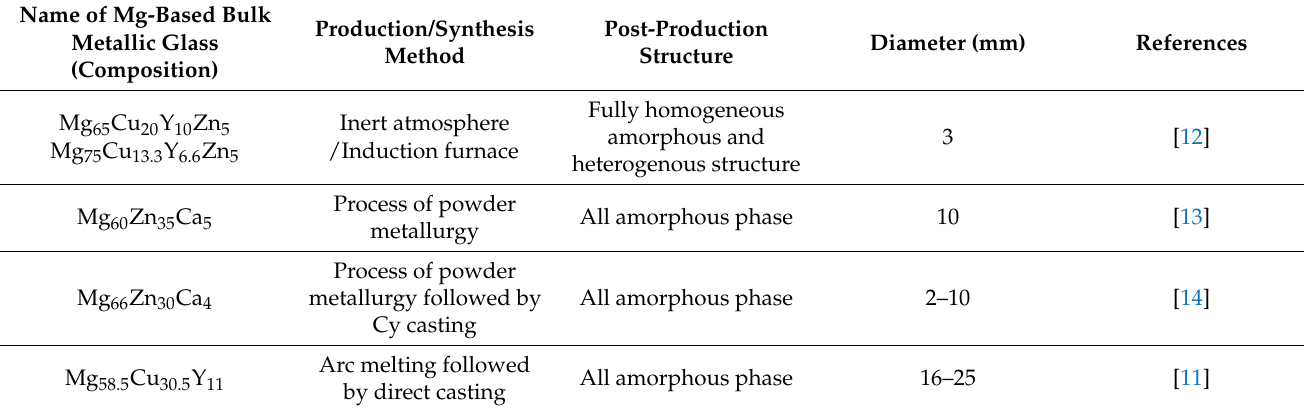
Table 1. Summary of reported synthesis routes of Mg-based